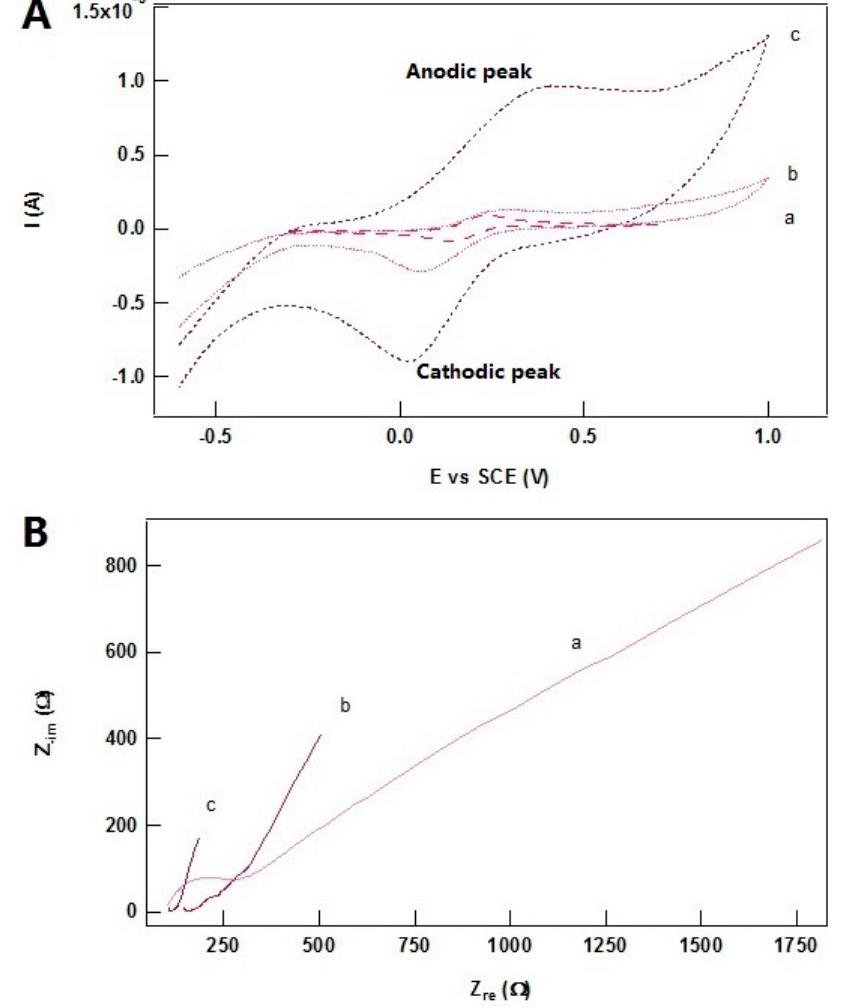
Figure 6. In ( A ), Cyclic voltammograms recorded in 5 mmol L − 1 K 3 [Fe(CN) 6 ]/K 4 [Fe(CN) 6 ] solution containing 0.1 mol L − 1 KCl at (a) GCE, (b) α -, γ -Fe/CNTs/CNOs buckypaper and (c) Fe 3 C/CNTs buckypaper produced in this work. Scan rate: 50 mV s − 1 . In ( B ), Nyquist diagrams obtained for (a) GCE, (b) α -, γ -Fe/CNTs/CNOs buckypaper and (c) Fe 3 C/CNTs in 5 mmol L − 1 K 3 [Fe(CN) 6 ]/K 4 [Fe(CN) 6 ] solution containing 0.1 mol L − 1 KCl.